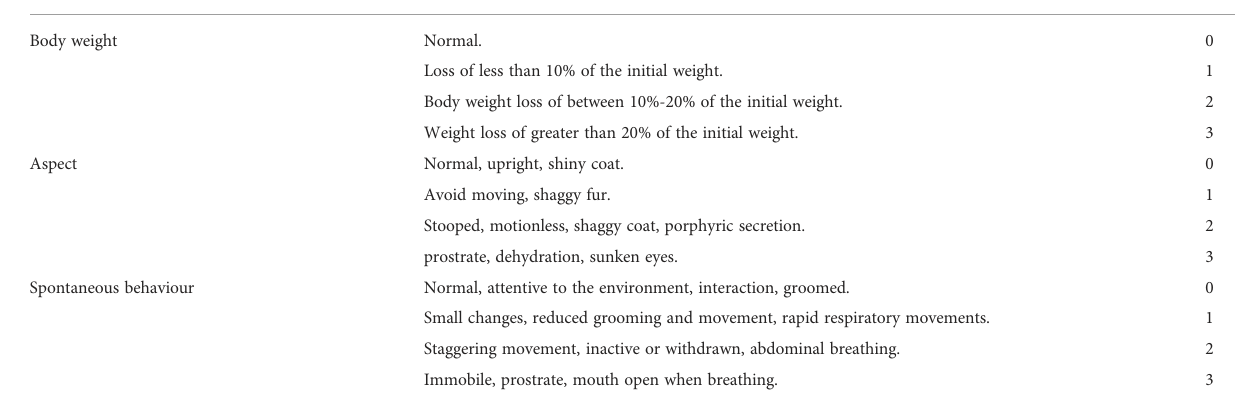
TABLE 1 Variables considered in the clinical